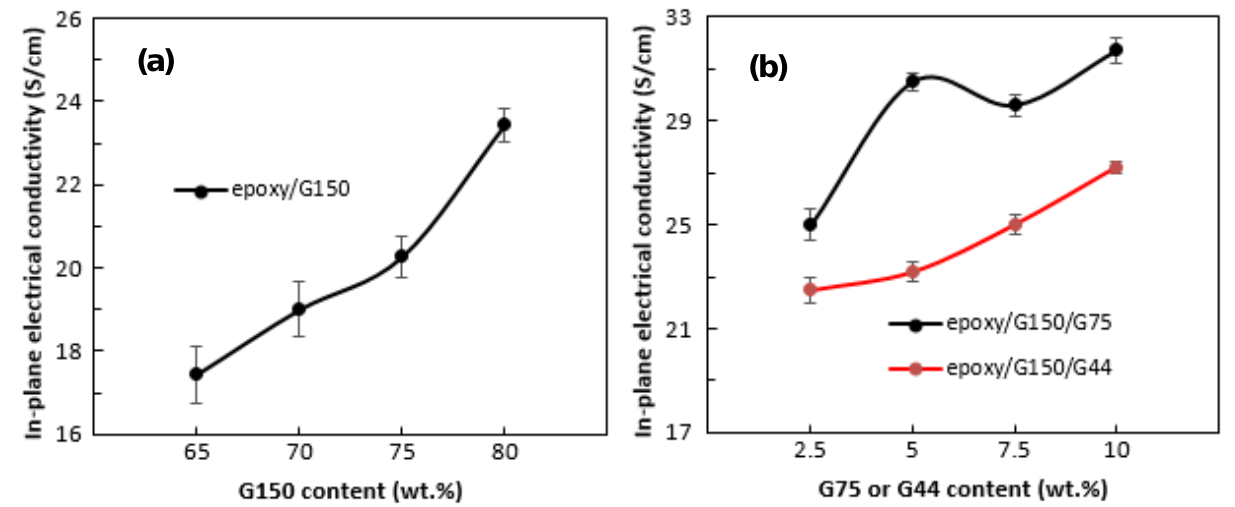
Figure 2. In-plane electrical conductivity values of the epoxy/G composites with different G particle sizes and contents: ( a ) epoxy/G150 and ( b ) epoxy/G150/G75 and epoxy/G150/G44 prepared at 110 °C for 60 min.